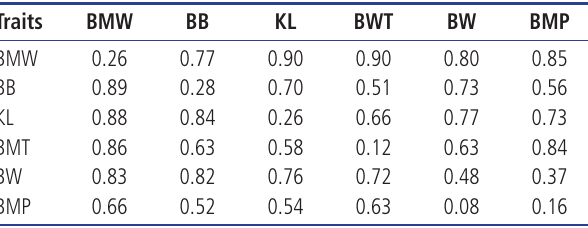
Table 2. Estimates of heritabilities 1) (on the diagonal), genetic correlations 2) (below the diagonal) and phenotypic correlations (above the diagonal) obtained for breast meat related traits Traits